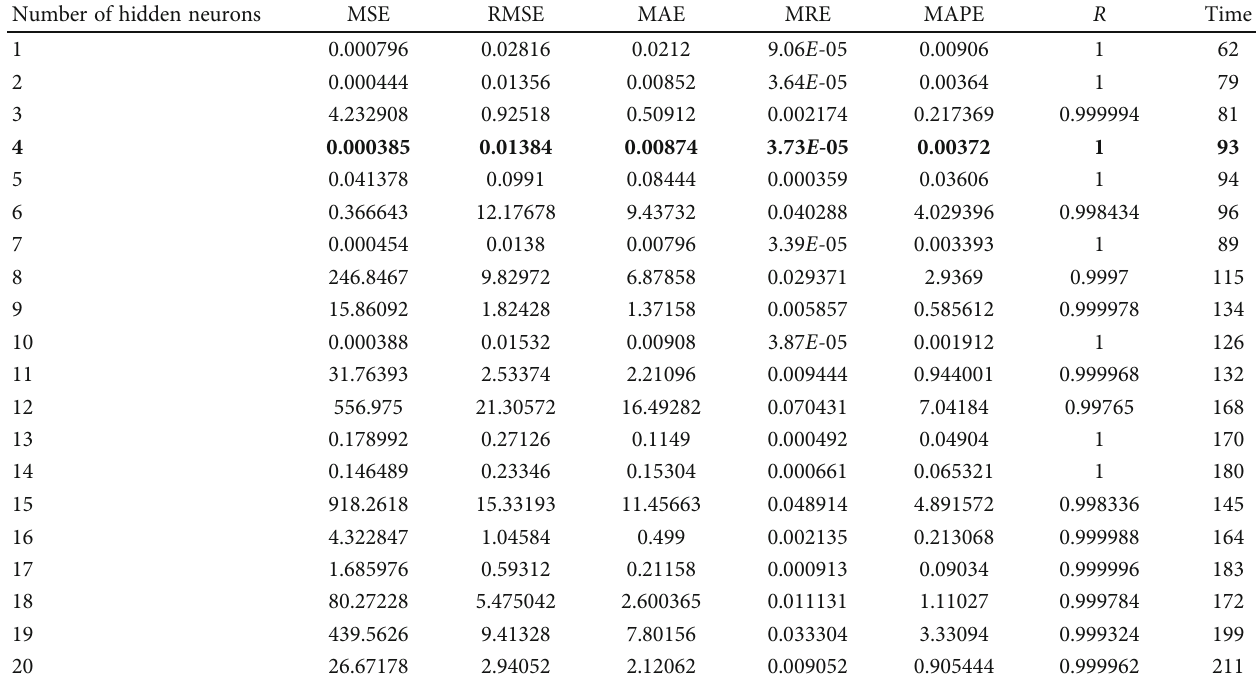
Table 8: Cooperative multi-input multilayer perceptron neural network performance analysis with di ff erent numbers of hidden neurons. Number of hidden neurons